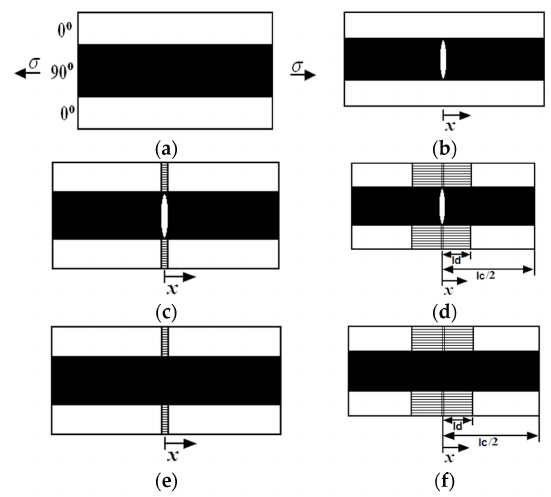
Figure 1. The undamaged state and five damaged modes of cross-ply ceramic composites: ( a ) undamaged composite; ( b ) mode 1: transverse crack; ( c ) mode 2: transverse crack and matrix crack with perfect fiber/matrix bonding; ( d ) mode 3: transverse crack and matrix crack with fiber/matrix interface debonding; ( e ) mode 4: matrix crack with perfect fiber/matrix bonding; and ( f ) mode 5: matrix cracking with fiber/matrix